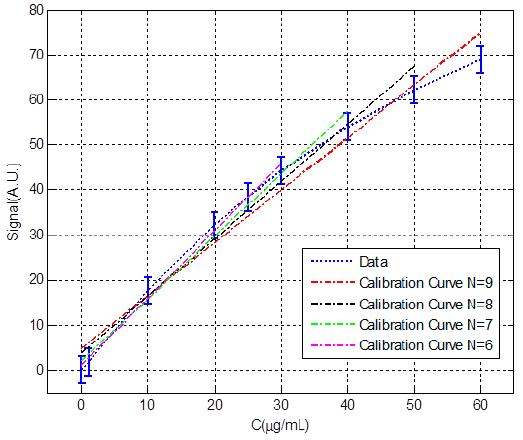
Figure 7. Data and calibration lines for different measuring intervals for the given example.